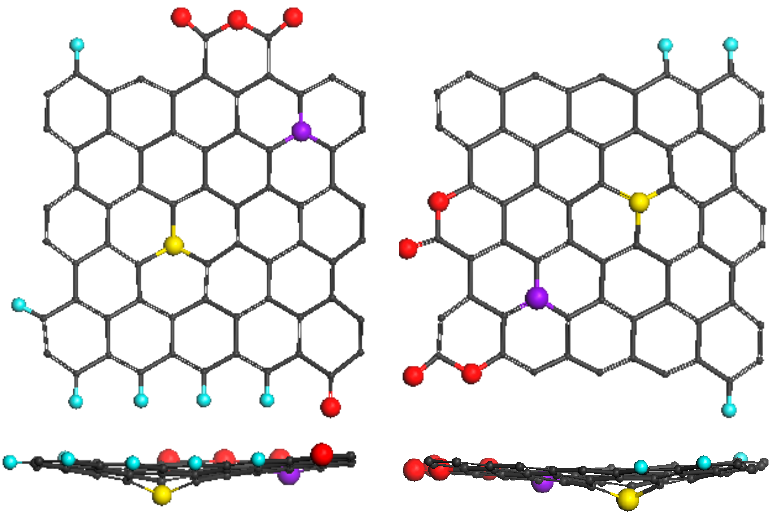
Figure 7. Top and side views of equilibrium structures of ShC_NS3 (C 66 O 4 NSH 6 ) ( left ) and CB632_NS3 (C 66 O 4 NSH 3 ) ( right ) GONSH molecules (see